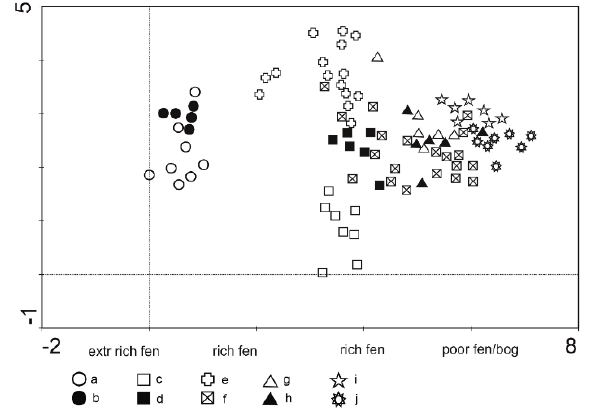
Figure 4. Results of Detrended Correspondence Analysis (DCA) of 128 relevées of mire vegetation in Slītere National Park, Latvia. Codes of species groups refer to the synoptic table